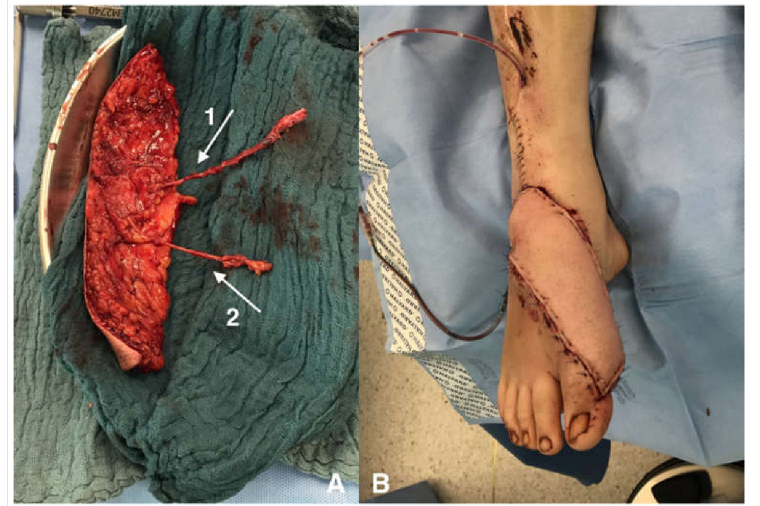
Figure 2. Example of an ALT flap, which can be used for neuroma salvage. ( A ) shows the cutaneous branch (2) besides the vascular pedicle (1), which has excellent length and diameter for providing a good recipient nerve as a new neurotizable target. ( B ) shows the application on the dorsal foot and ankle region, where only a thin soft tissue layer covers the superficial